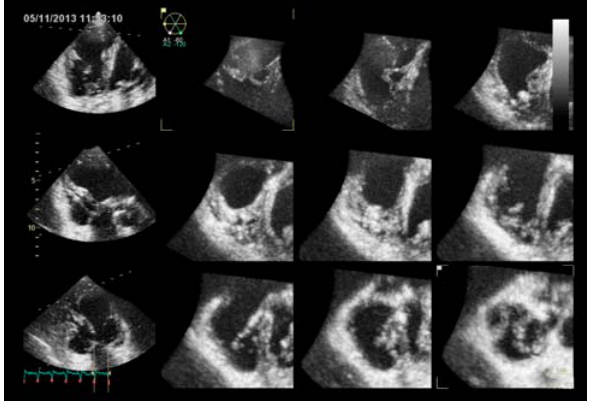
Figure 5. Three-dimensional echocardiography of the right ventricle in a pulmonary hypertension patient, showing three apical views and corresponding short